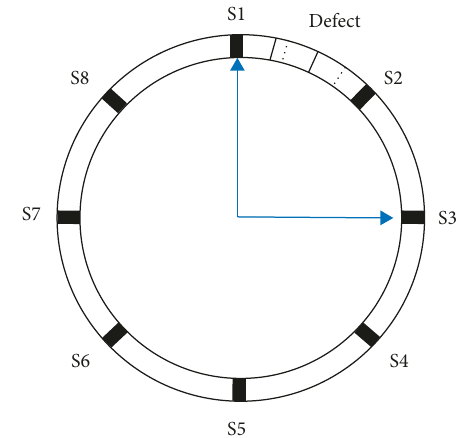
Figure 24: Schematic diagram of the defects and sensor